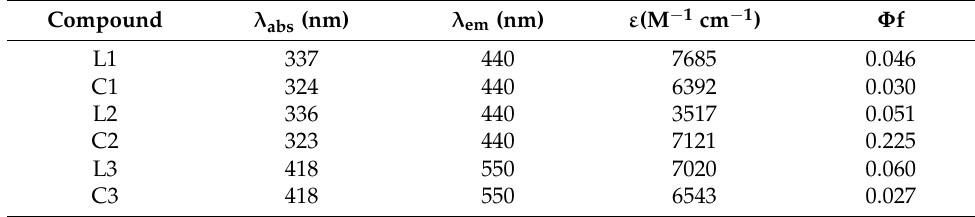
Table 1. Spectroscopic properties of ligands and